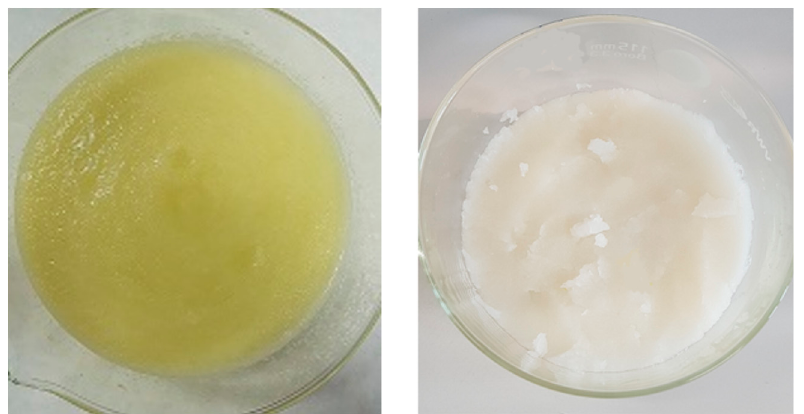
Figure 9. Pulp slurry-meal from winter-melon ( Cucumis Inodorous ): natural ( left ) and bleached pomace ( right